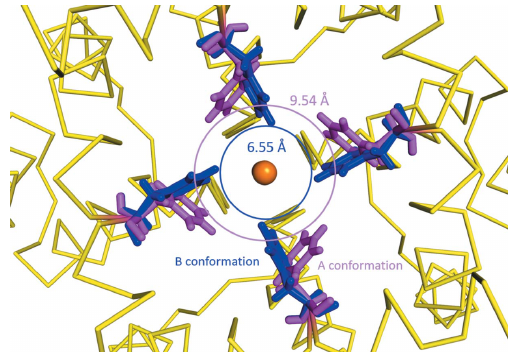
Figure 5 The A and B conformations of Phe92 observed in our structure create pores with different diameters at the exit of the selectivity filter. The A conformation of Phe92 shown in magenta creates a pore with a diameter of 9.54 A˚ , which we refer to as the enlarged pore. The B conformation of Phe92 shown in blue creates a pore with a diameter of 6.55 A˚ , which we refer to as the restricted pore. We are defining the pore diameter as the shortest distance between atoms on opposing Phe92 residues in the ion channel based upon our crystal